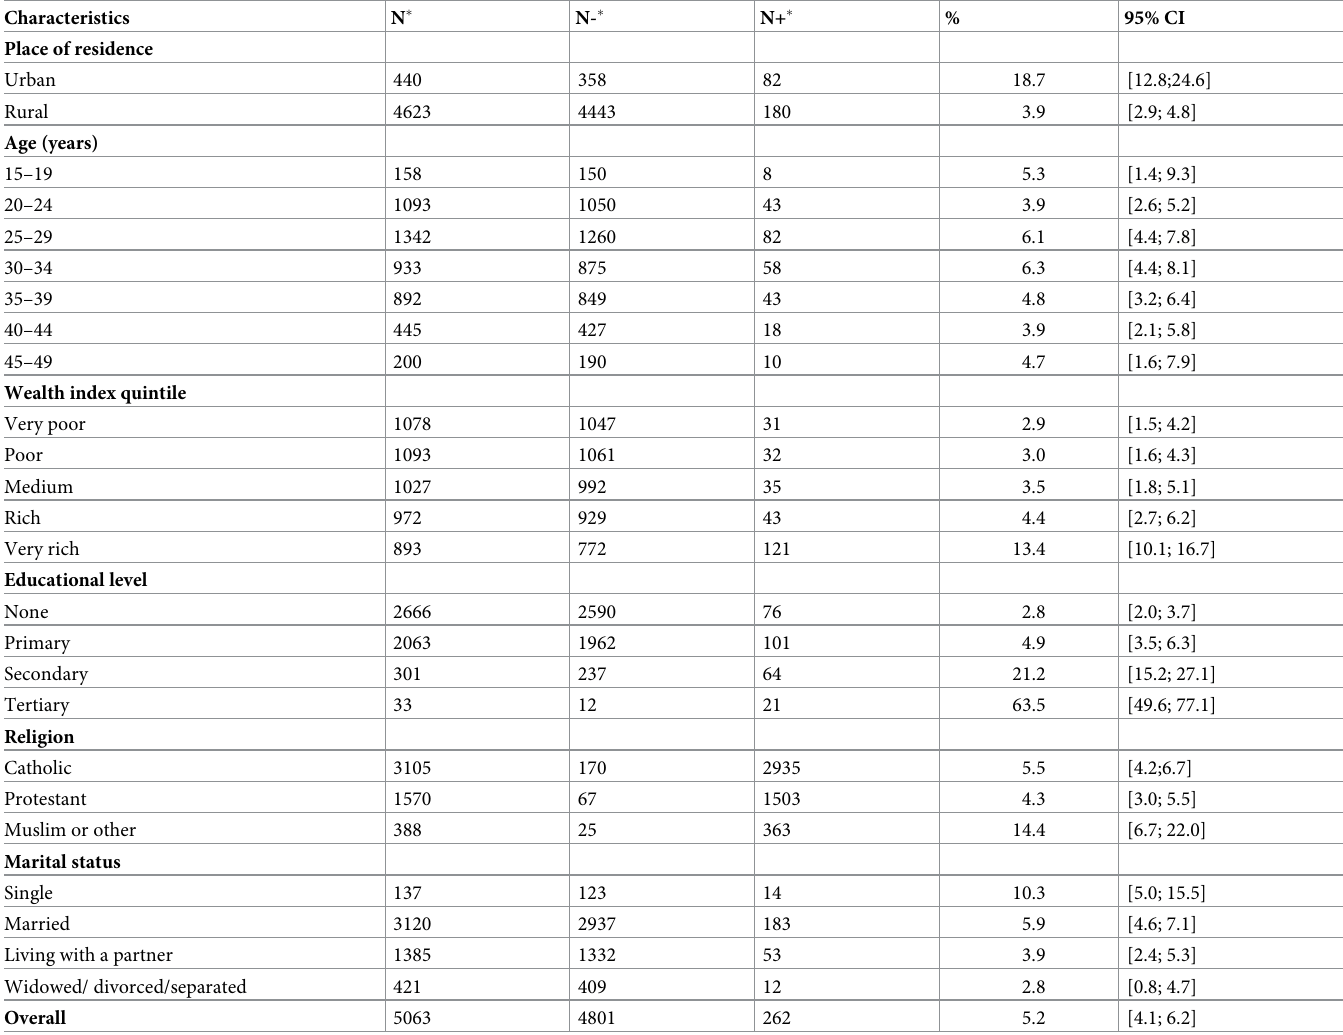
Table 3. Distribution of antenatal care by socio-economic